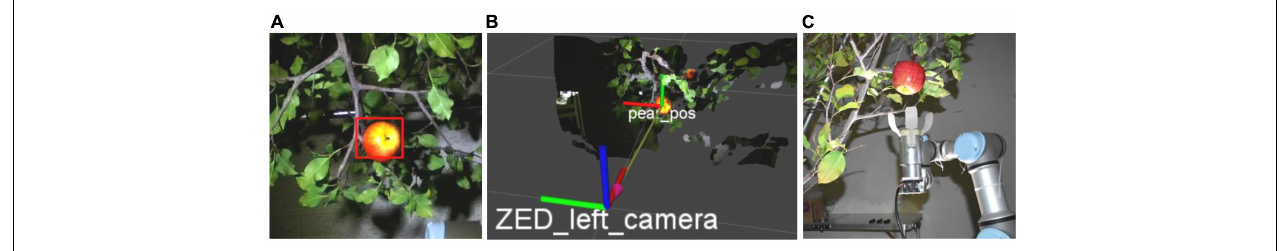
FIGURE 16 | Automatic apple harvesting mode in Onishi et al. (2019). (A) Detection of a two-dimensional position, (B) detection of a three-dimensional position, (C) approaching the target apple.